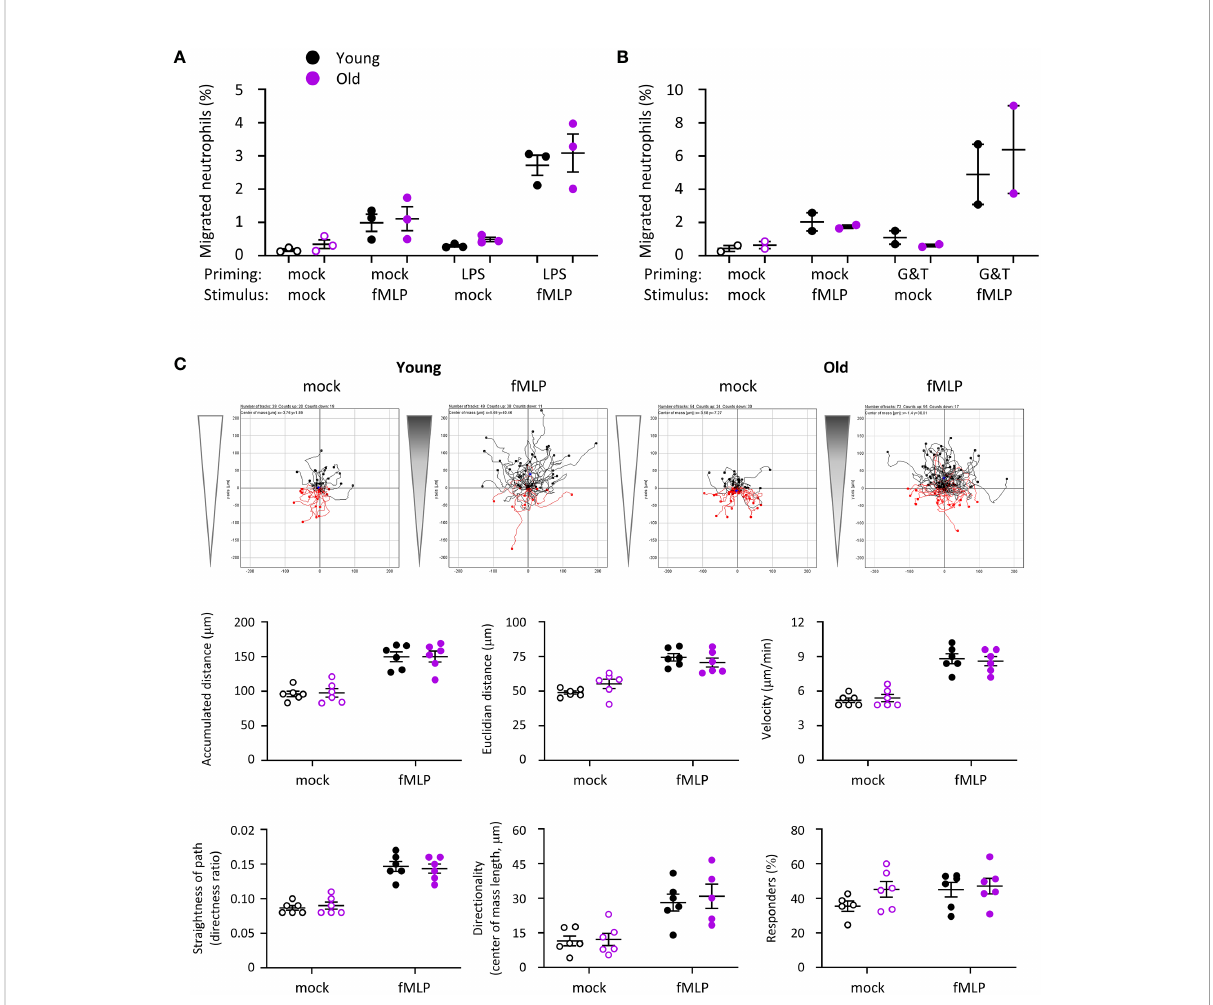
FIGURE 6 Hornigold K et al. Migration is normal in neutrophils from old mice. (A, B) Transwell assay. Bone marrow cells from young (8-10 weeks, black symbols) and old (24 months, purple symbols) mice were (A) primed with 1 m g/ml LPS or mock-primed for 90 min at 37°C, or (B) primed with 50 ng/ml GM-CSF and 20 ng/ml TNF a or mock-primed for 45 min, before placing them into the top well of transwell fi lters with 3 m M pores and stimulation with 1 m M fMLP, or mock-stimulation with buffer only, in the bottom well for 40 min at 37°C. Transmigrated and total neutrophils were quantitated by fl ow cytometry. Data are mean ± SEM of 3 independent experiments in (A) and 2 in (B) ; each dot represents the mean of one experiment. (C) Ibidi chamber assays. Isolated neutrophils from young or old mice as in (A) were primed with 50 ng/ml GM-CSF and 20 ng/ml TNF a for 45 min and seeded into ibidi chambers coated with 20 m g/ml pRGD. Cells were allowed to adhere for 20 min at 37°C before establishing a gradient with 10 µM fMLP at one end of the chamber ( fi lled symbols), or a mock-gradient with buffer only (open symbols), and neutrophils were live-imaged for 20 min (frames every 10 s) using an Olympus CellR microscope. Cells were tracked and migration quantitated using the ‘ chemotaxis and migration ’ plugin of ImageJ. Top panels show representative tracks from one experiment, other panels quantify the indicated parameters of cell speed and directionality obtained from ImageJ. Data are mean ± SEM of 6 independent experiments with tracks from 25-72 cells per condition in each experiment; each dot represents the mean of one experiment. Statistics in (A) and (C) were two-way ANOVA and revealed no differences between the